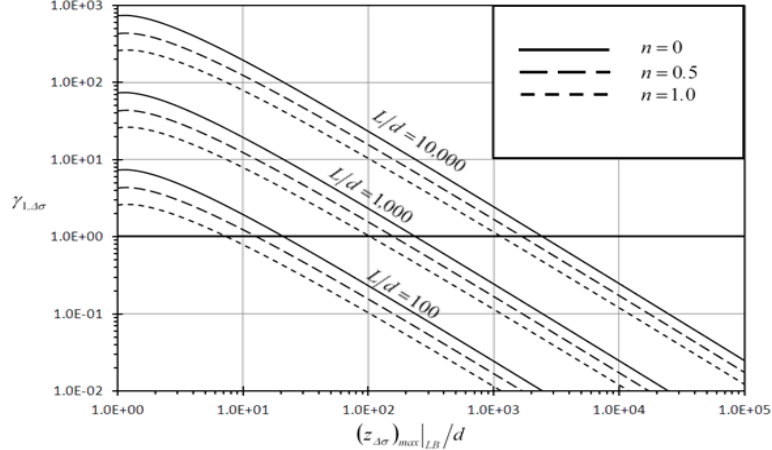
Figure 5. Effects of maximum rectangular microcantilever with long-slit side beams { } ( ) dimensionless deflection dz , the slit profile dimensionless length ( L / d ), and LBmax σΔ power law index ( n ) on the first detection enhancement indicator due to prescribed surface stress loading ( γ 1, ∆ σ